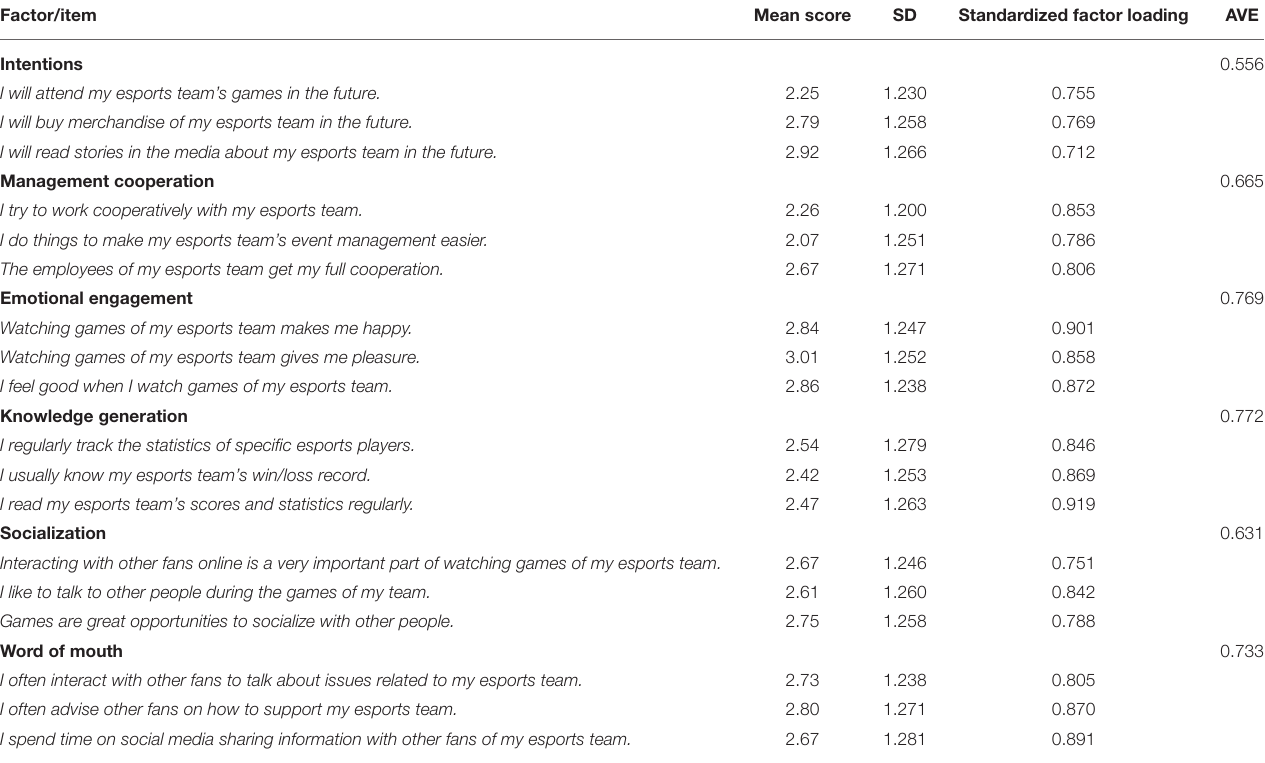
TABLE 3 | Confirmatory factory analysis (CFA) results.